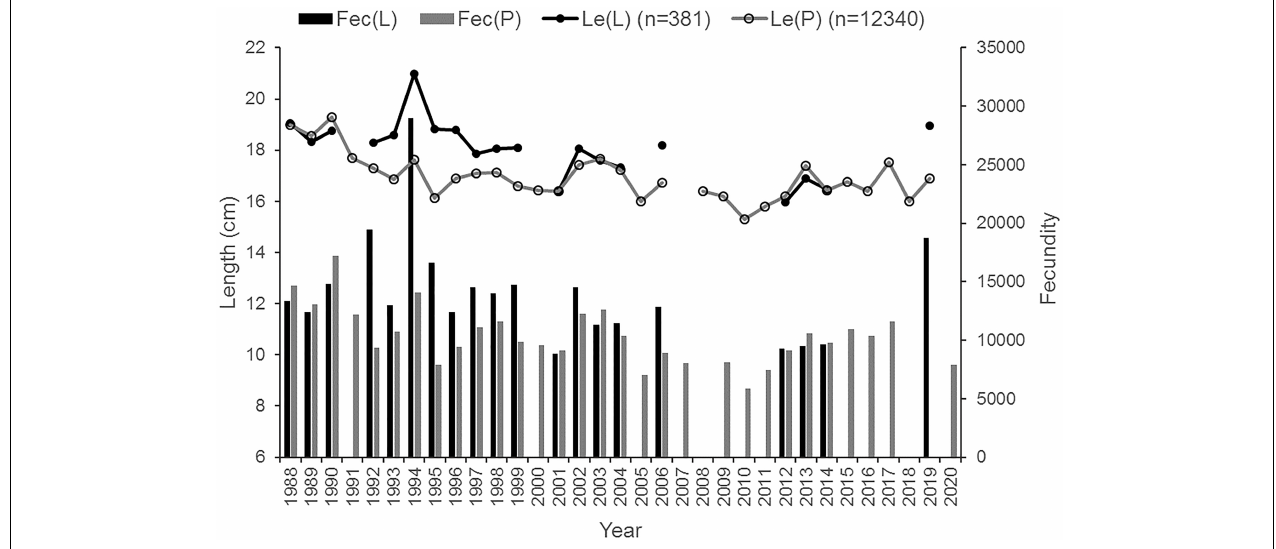
FIGURE 2 | Mean length (cm) of the Baltic herring females in the lipid samples (LeL) and in the spawning population (LeP), and the mean number of eggs in the females in the lipid [Fecundity = Fec(L)] and population samples [Fec(P)] in different years (n = number of females in the samples; for the data; see